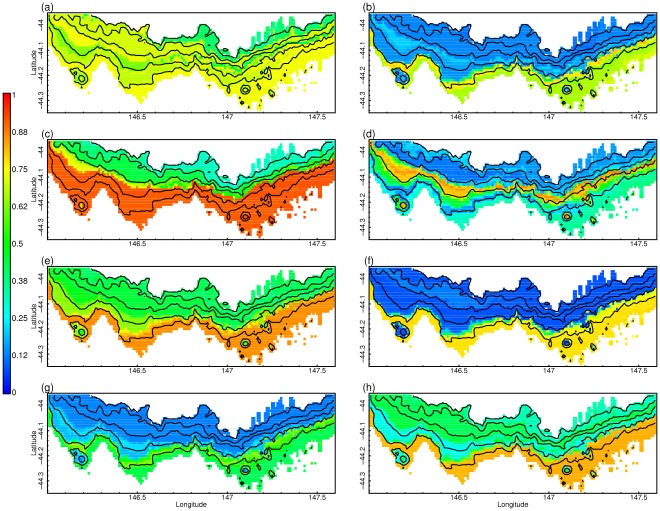
Distributions of eight of the most frequently occurring species of megabenthos from the deep continental margin south of Tasmania, Australia.The distributions are shown for: (a) Ophiactis abyssicola; (b) Ophiomyxa MoV5486; (c ) Munida isos; (d) Goreopagurus poorei (e) Solenosmilia variabilis; (f) Desmophyllum dianthus; (g ) Farrea cf. occa; (h) Jaffaia jaffaensis. Bathymetry contours are 200 m, 400 m, 600 m, 1000 m, and 1200 m.